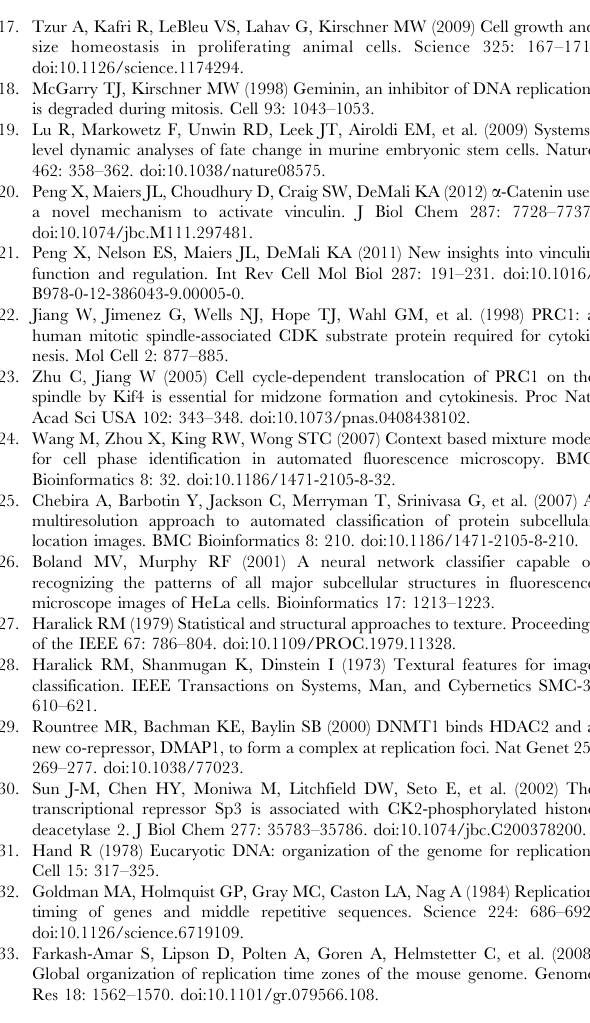
3:610–621. (TIF) Figure S8 Cell-cycle dependent expression of proteins doesn’t correlate with replication timing of the gene. Genes were sorted based on their time of replication during the S phase (taken from : Farkash-Amar S, Lipson D, Polten A, Goren A, Helmstetter C, Yakhini Z & Simon I (2008) Global organization of replication time zones of the mouse genome. Genome Res. 18:1562–1570). Note that there is no evident pattern indicating that early gens accumulates protein earlier than late genes. (TIF) Figure S9 Analysis of cell-cycle dependency of protein level using the median pixel. On the left, the median average profile is shown when using the median pixel. On the right, Bootstrapping approach was used to determine the threshold for cycling genes based on median pixel. Similar analysis to the analysis descibed in Figure S1 was done here for protein profiles based on the median pixel instead of the total protein. The score of the 90th deviation from the mean profile was calculated for the 100 sets of 4 FOVs (Fields of View). Given these histograms, a